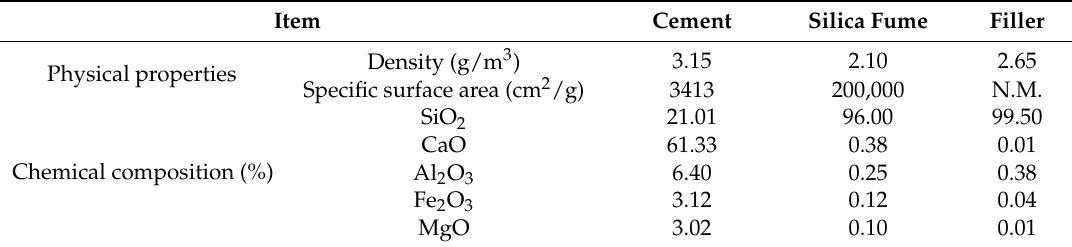
Table 2. The properties of cement, silica fume, and